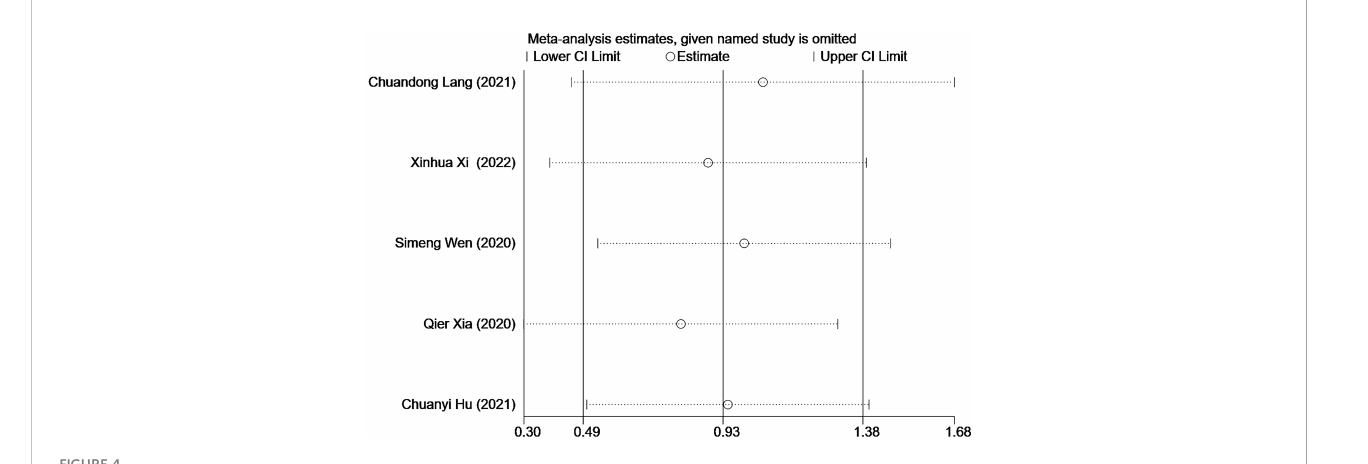
FIGURE 4 Sensitivity